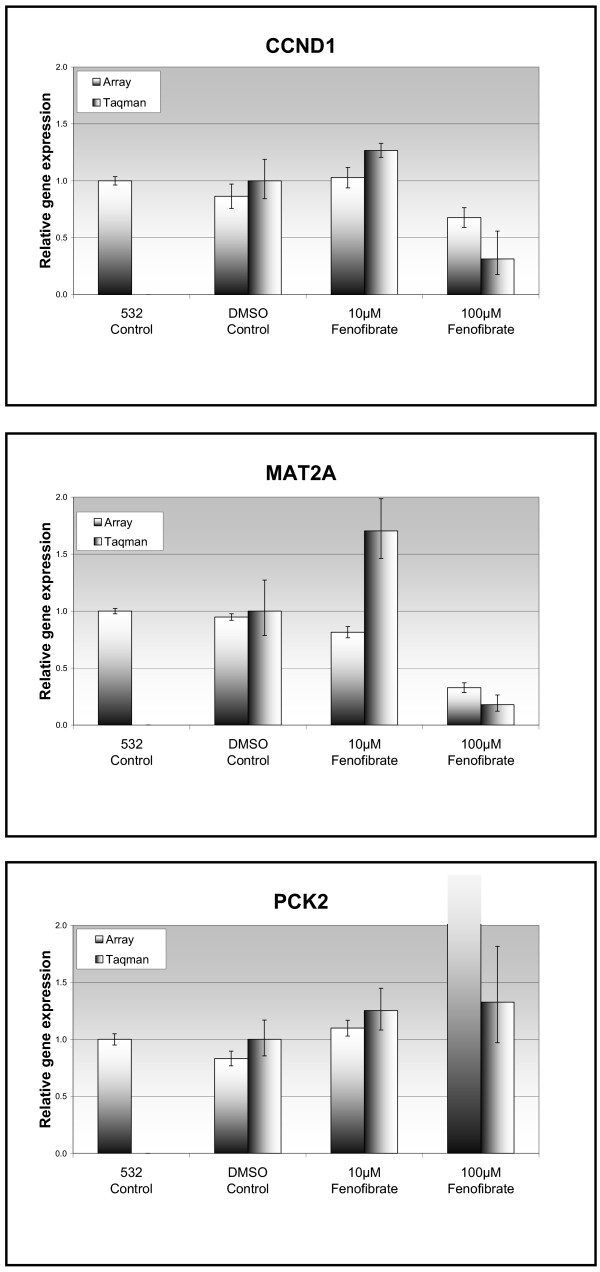
Comparison between array data and gene expression (as measured using Taqman RT-PCR). The "532 control" column represents the green-channel array data from the pooled cDNA (from DMSO-treated control samples) and is used as an internal control. Three genes were chosen for verification of the array: top – Cyclin D1, middle – Methionine Adenosyltransferase 2-alpha, bottom – Phosphoenolpyruvate carboxykinase 2.